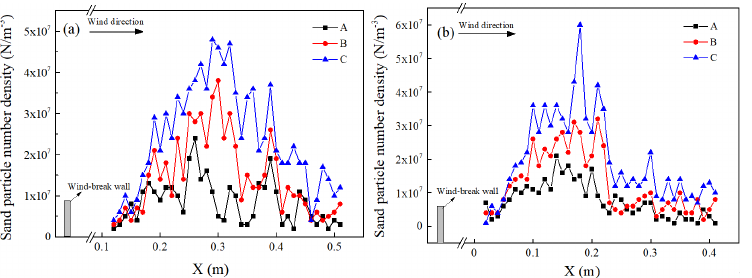
Figure 10. Number density of sand particles ( u ∗ = 0.9701 m/s). ( a ) H = 0.05 m (above the track). ( b ) H = 0.10 m (above the